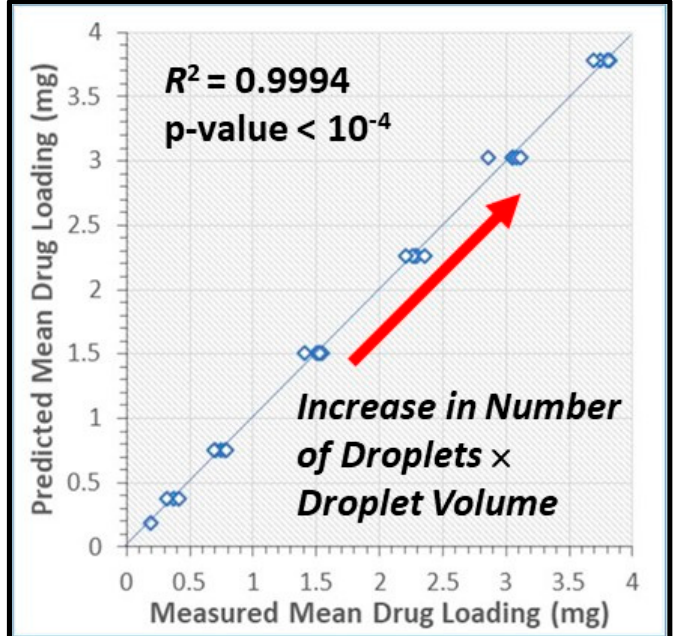
Figure 9. Mean drug content predicted by Equation (3) vs. the measured mean drug content in the printed films. Note that N d × V d was set at 1, 2, 4, 8, 12, 16, and 20 µ L to attain 7 di ff erent levels of drug content presented in the figure. The variability observed along the horizontal direction is associated with the use of 29 di ff erent N d − V d pairs in the